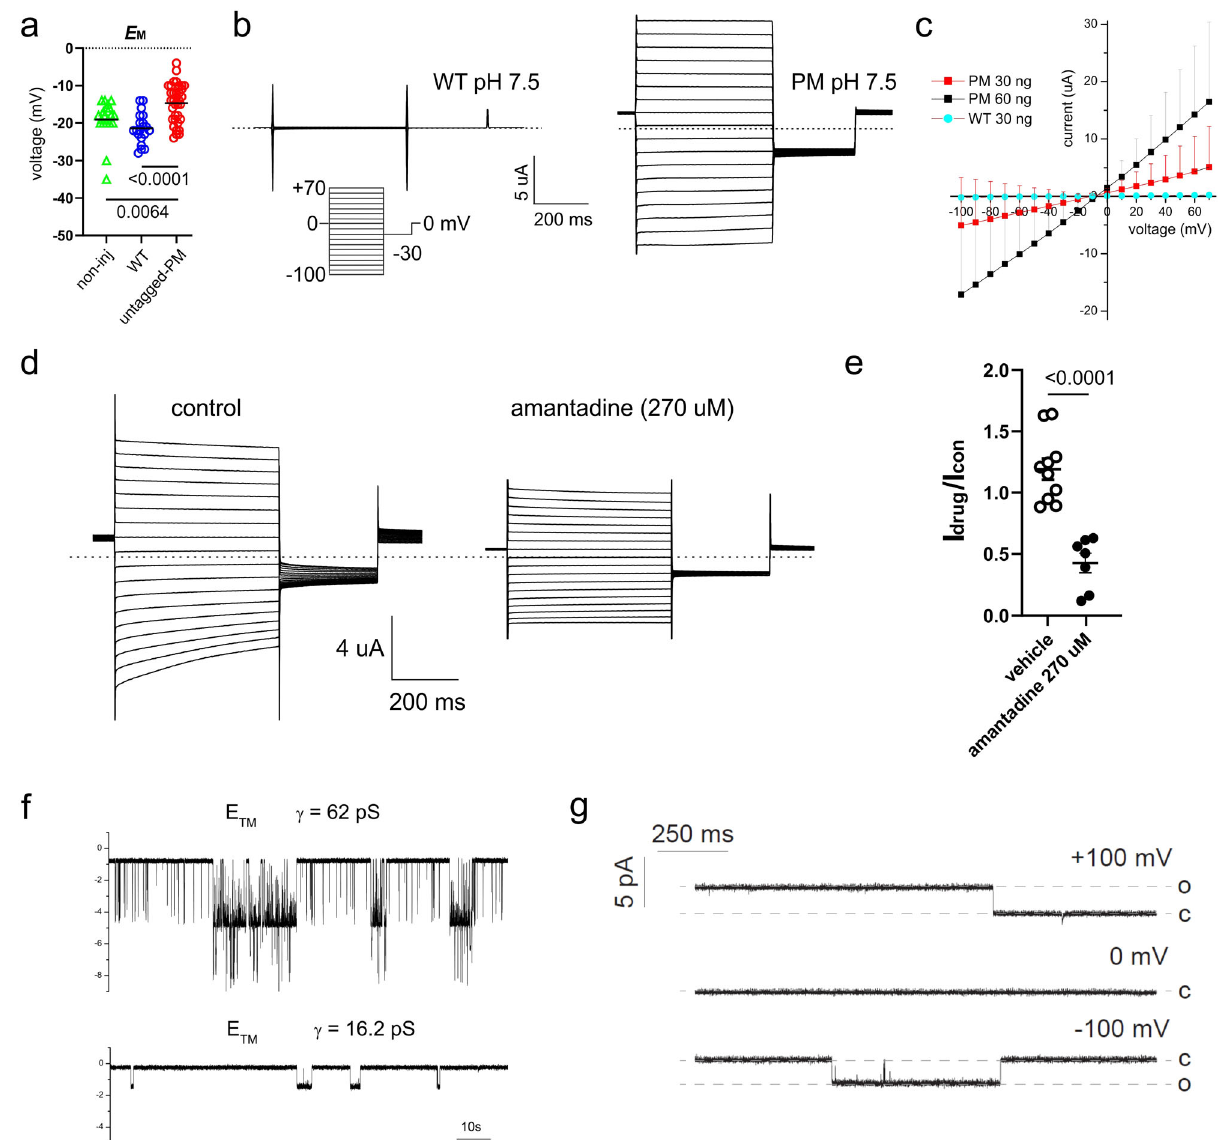
Fig. 1 SARS-CoV-2 E protein forms a cation channel in cells and arti fi cial bilayers. a Scatter plot of the resting (unclamped) membrane potential ( E M) for Xenopus oocytes expressing untagged-PM ( n = 35), WT ( n = 20) or non-injected (non-inj) oocytes (triangles, n = 20) (statistical analysis by one-way ANOVA ( P = 0.0002) and Tukey ’ s post hoc test, untagged-PM vs. WT, P < 0.0001; untagged-PM vs. non-inj, P = 0.0064; WT vs. non-inj, P = 0.3290). Data reproduced by permission from ref. 3 . b Exemplar current traces for oocytes expressing WT (left panel) and untagged-PM (right panel) as indicated, at pH 7.5 (30 ng cRNA). Voltage protocol and scale bars are shown in the inset. Dashed lines indicate zero current level. Data reproduced by permission from ref. 3 . c Large amplitude ( µ A) membrane currents on the expression of SARS-CoV-2 E protein are proportional to the quantity of RNA injected. Mean peak current versus voltage for oocytes after injection of 30 ng (red squares, n = 17) or 60 ng (black squares, n = 8) “ untagged-PM ” E protein cRNA, or after injection of 30 ng “ WT ” E protein cRNA (circles, n = 15). cRNA encoding WT and untagged-PM constructs was generated from cDNA in the pXOOM vector. Current data shown are mean ± SD, and are reproduced by permission from ref. 3 . d Exemplar current traces for oocytes expressing untagged-PM E protein in the absence (control) or presence of amantadine (270 µ M) at pH 7.5 (30 ng cRNA). Voltage protocol and scale bars are shown in the inset. Dashed lines indicate zero current level. Other experimental methods are described in ref. 3 . e Scatter plot of fractional current at − 80 mV remaining after incubation of oocytes expressing untagged-PM E protein in bath solution (vehicle) ( n = 10) or amantadine (270 µ M) ( n = 7) as in ( d ). Statistical analysis performed by unpaired, two-tailed t test; bars indicate mean; error bars indicate SEM. f Single-channel currents recorded on reconstitution of a synthetic transmembrane (TM) fragment (amino acids 8 – 38) of E protein into arti fi cial bilayers. The lipoprotein particles used to deliver the TM fragment into the lipid bilayer were prepared by using the protocol described in ref. 6 for the pentameric structure formation. Recordings were made in symmetrical 300 mM NaCl, 5 mM MgCl 2 , 10 mM HEPES, pH 7.2, and low-pass fi ltered at 50 Hz for display purposes. g Single-channel currents following the reconstitution of recombinant E protein into arti fi cial bilayers using lipid nanodiscs 5 . E protein from cell-free protein expression in presence of lipid nanodiscs recorded in suspended lipid bilayer 4:1 DPhPC:DPhPS, in symmetrical 250 mM KCl, 10 mM HEPES, pH 7.4, 1 mM EGTA at + 100 mV (upper trace), 0 mV (middle trace) and − 100 mV (lower trace). Data were low-pass fi ltered at 500